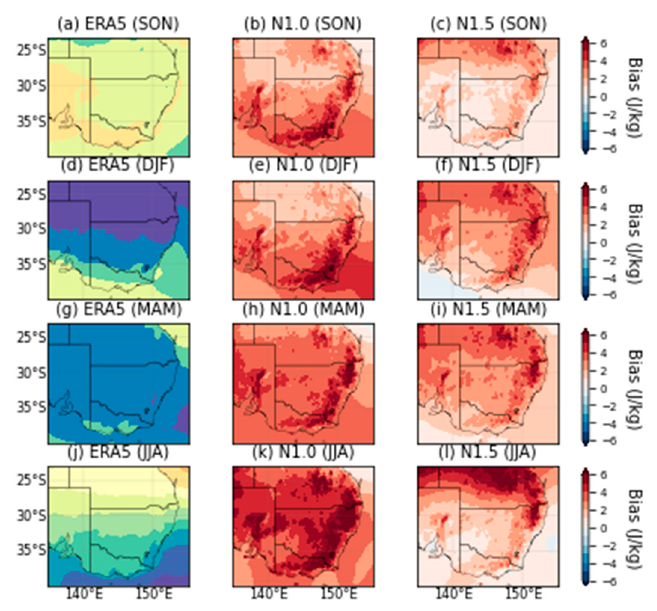
Figure A19. As in Figure A15 except for S06. Unit: m s − 1 .